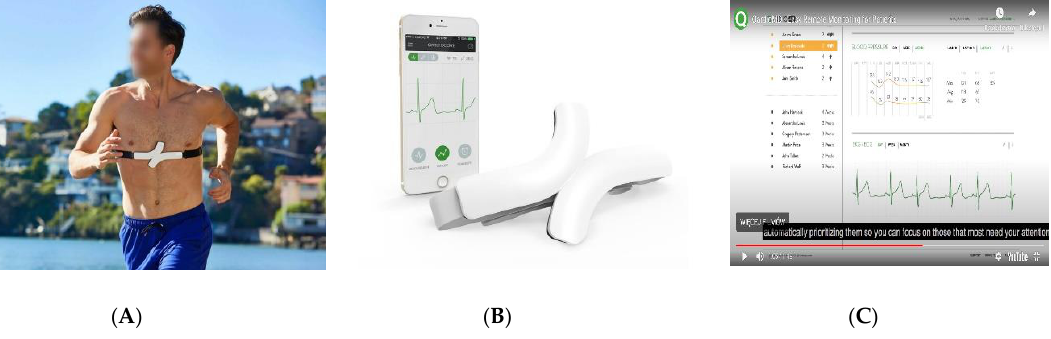
Figure 4. QardioMD ECG solution (QARDIO MD system). ( A ) QardioCore ECG—chest strap with electrode. ( B ) Qardio mobile app (ECG recording on iPhone) and chest strap (QardioCore ECG) with electrode. ( C ) ECG recording on QardioMD remote monitoring web-based portal.